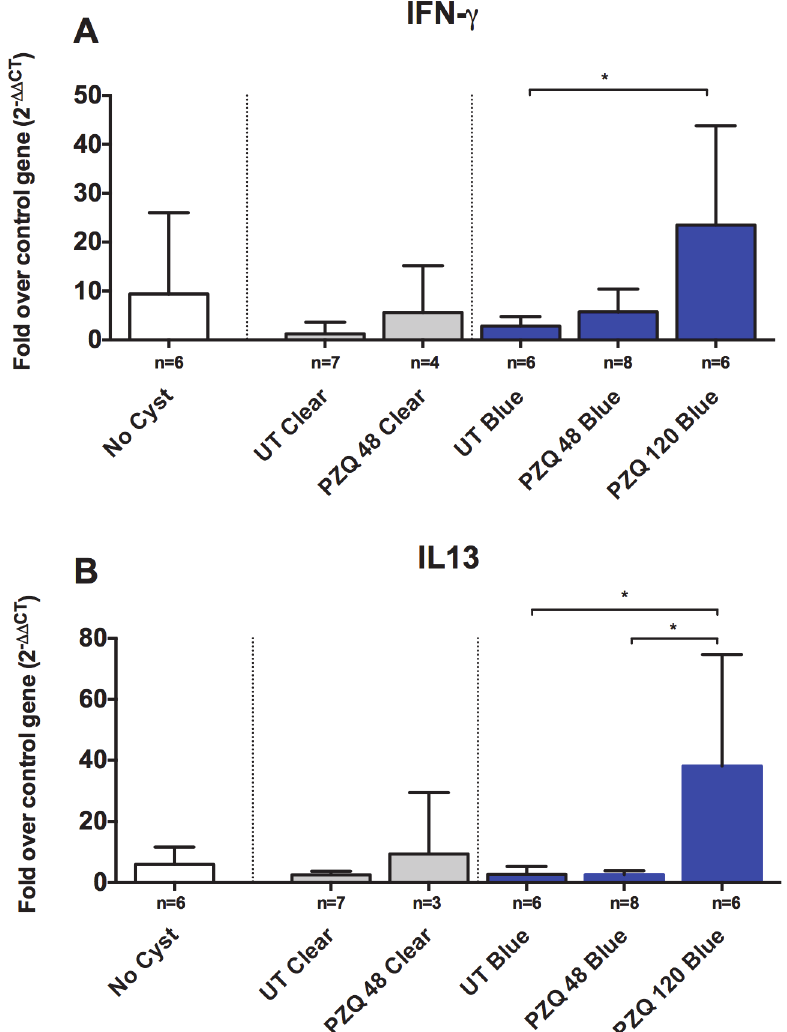
Fig 4. Upregulation of both Th1 and Th2 markers, IFN- γ and IL-13, in blue capsules following PZQ treatment. Expression levels of RNA in brain tissues and EB-stained and clear capsules for IFN- γ (A; number [n] of samples for the indicated types of capsules are shown below each bar), and IL-13 (B). In each graph, the bars represent means and CI 95 for the group. Statistically significant differences in levels of gene expression are indicated by asterisks (p < 0.05, Mann-Whitney U test). Asterisks represent level of significance: * : p < 0.05; ** : p < 0.01; *** : p <